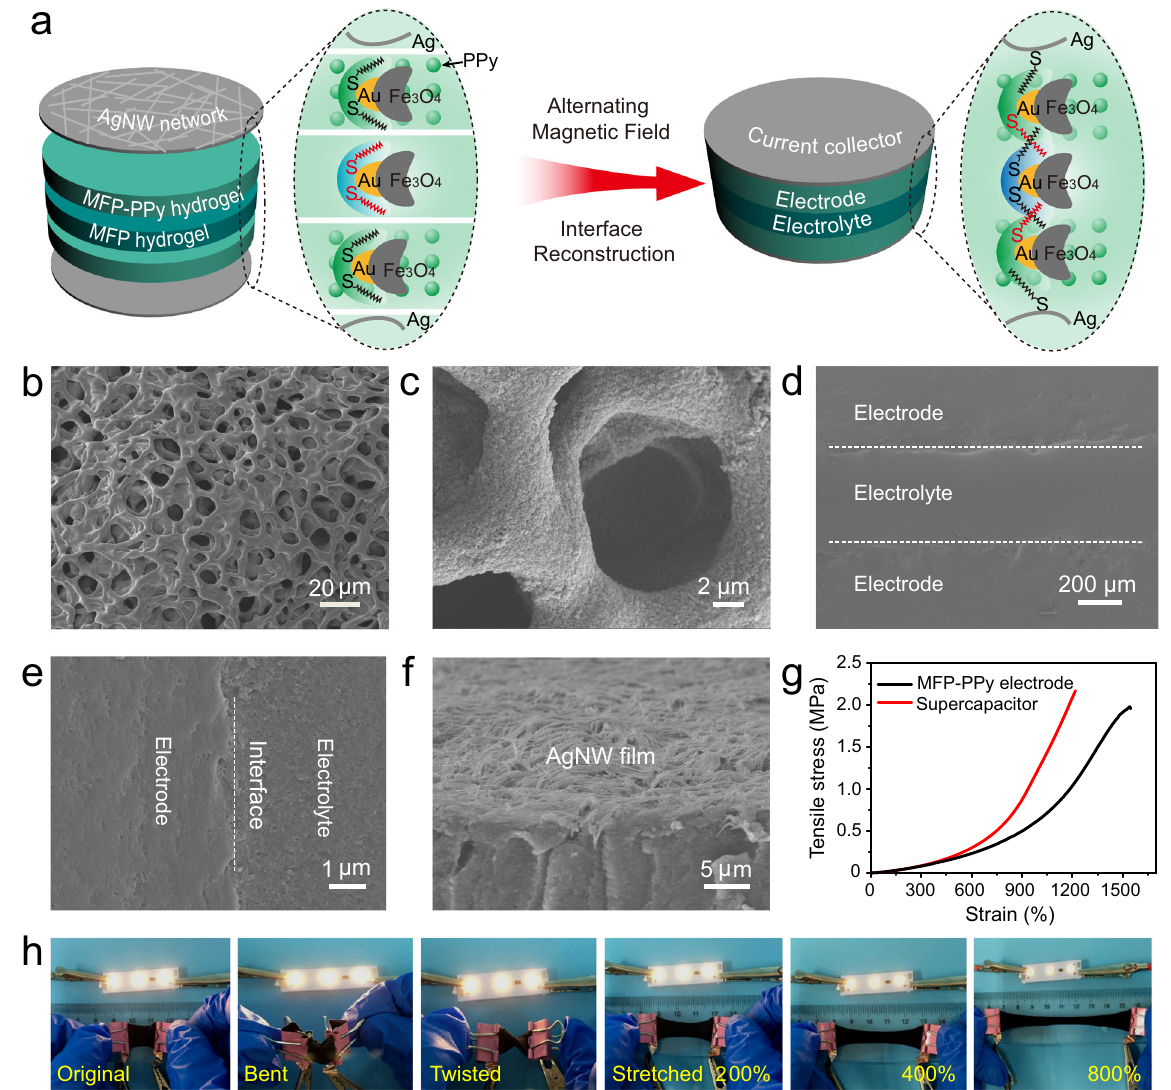
Fig. 3 Assembly of the healable supercapacitor device. a Schematic illustrations of the magneto-thermal induced assembly of the supercapacitor by sandwiching two MFP-PPy hydrogel electrodes with a MFP hydrogel electrolyte and spraying AgNW fi lm layers as current collectors. The device presents an integrated con fi guration owing to the metal-thiolate bond-triggered interface reconstruction under alternating magnetic fi eld. SEM image ( b ) and enlarged SEM image ( c ) of MFP-PPy hydrogel electrode. d Cross-sectional SEM image of the supercapacitor. e Enlarged SEM image of the electrode/ electrolyte interface of the supercapacitor. f SEM image of the AgNW fi lm coated on the electrode. g Tensile stress – strain curves of the MFP-PPy hydrogel electrode and the assembled supercapacitor. h Optical images show good electrical conductivity of the supercapacitor at multiple deformations including bending, twisting, and stretching with high